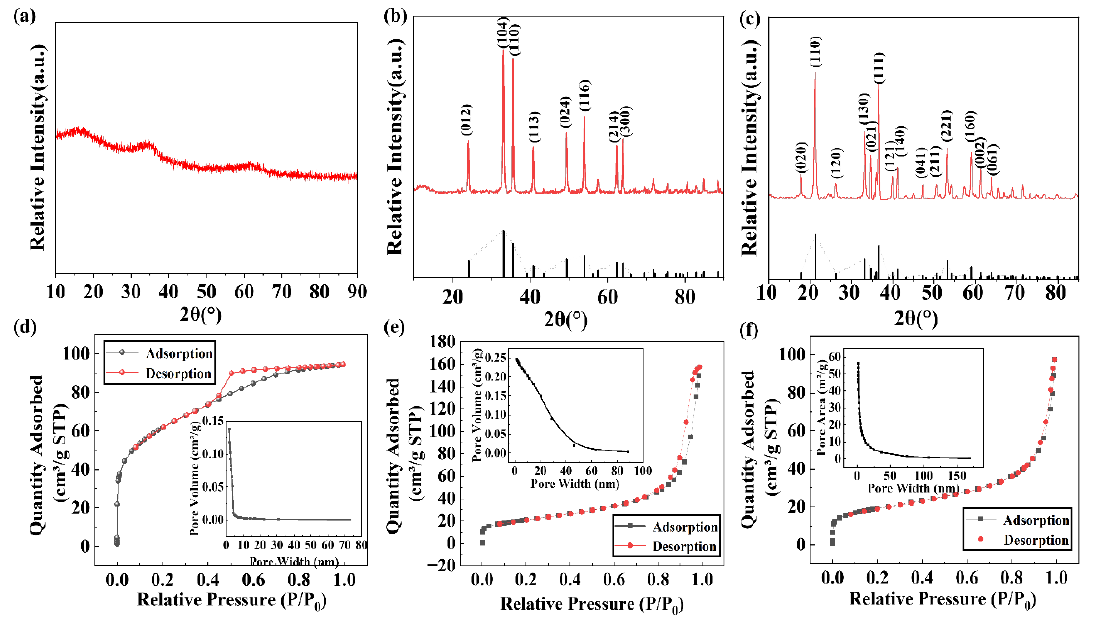
Figure 2. XRD patterns of iron minerals with different crystallinity: ( a ) ferrihydrite, ( b ) hematite, and ( c ) goethite. N 2 adsorption/desorption isotherms and pore size distribution of ( d ) ferrihydrite, ( e ) hematite, and ( f ) goethite. a.u.—arbitrary units.